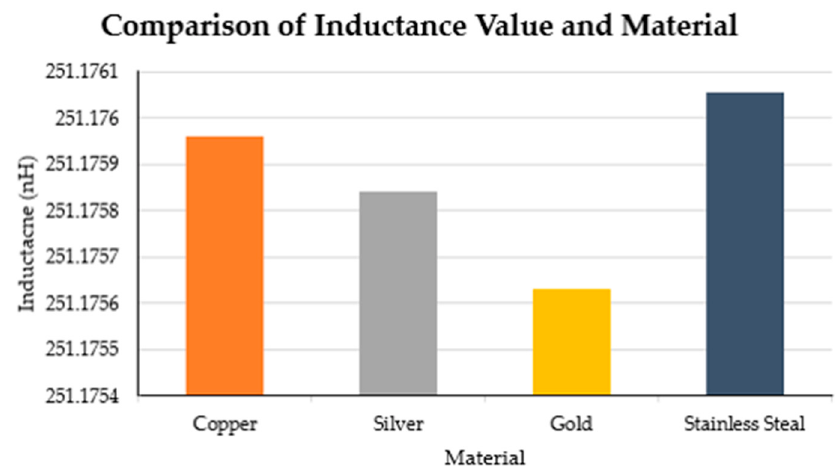
Figure 6. Comparison of simulated inductance value of the same sensor using copper, silver, gold, and stainless steel.